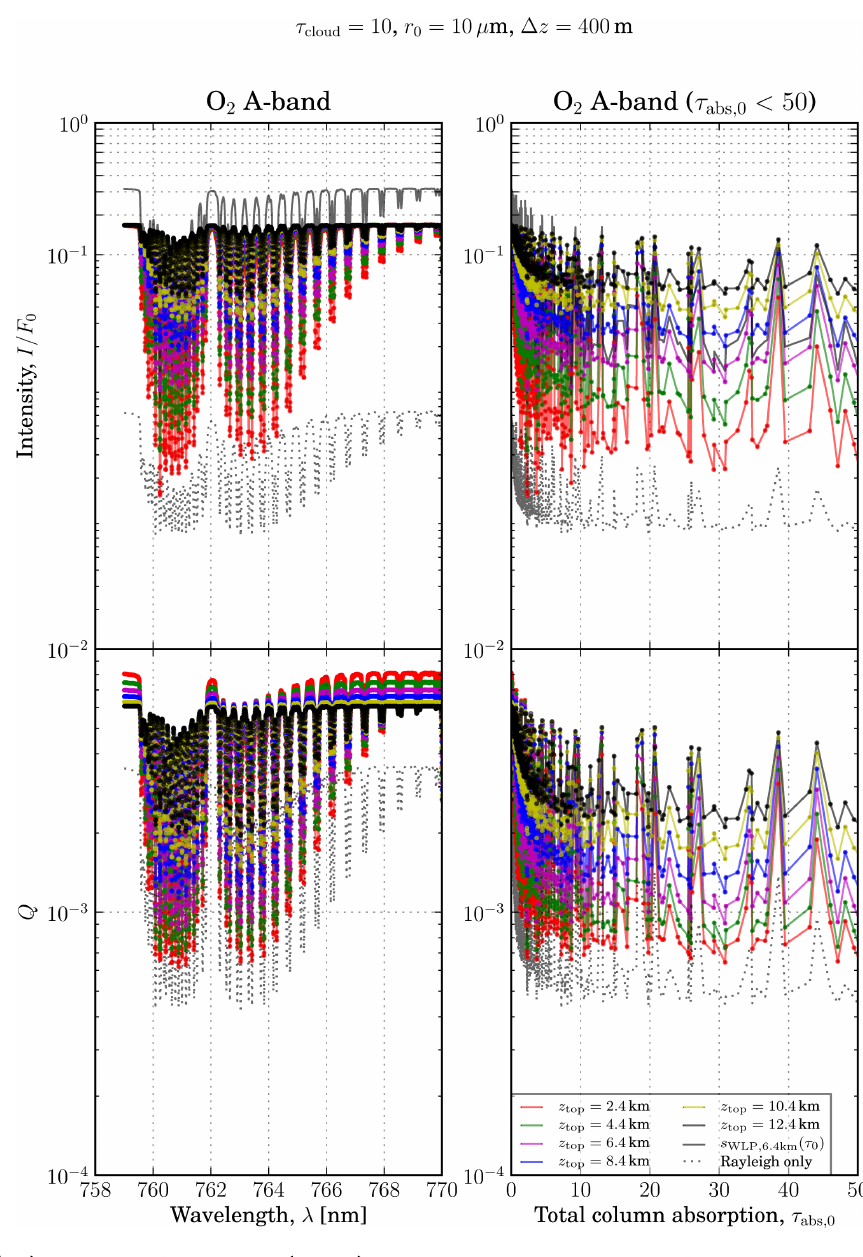
Figure 6. Intensity (top) and degree of polarization (bottom) due to a cloud-laden atmosphere of constant cloud optical depth, τ cloud = 10, with a median droplet radius of r 0 = 10µm but varying cloud z top (but constant geometric thickness (cid:49)z = 400m) in the O 2 A